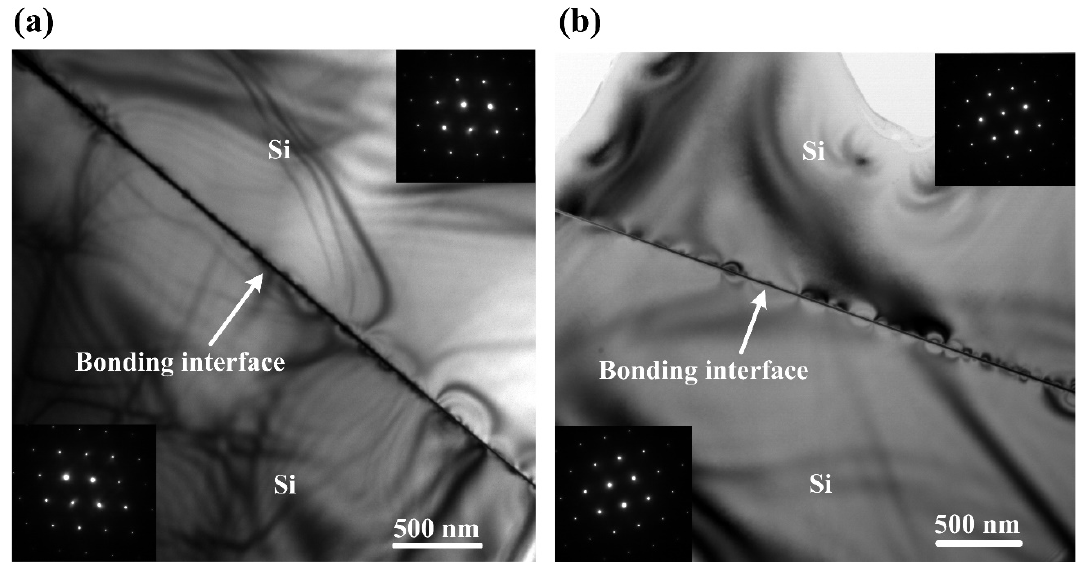
Figure 5. Low-magnification cross-sectional TEM images (10 4 times) of the bonding interfaces with two illustrations showing the diffraction patterns of the Si wafers in the two bonded Si-Si specimens activated under the Ar ion beam currents of ( a ) 10 mA and ( b ) 30 mA.